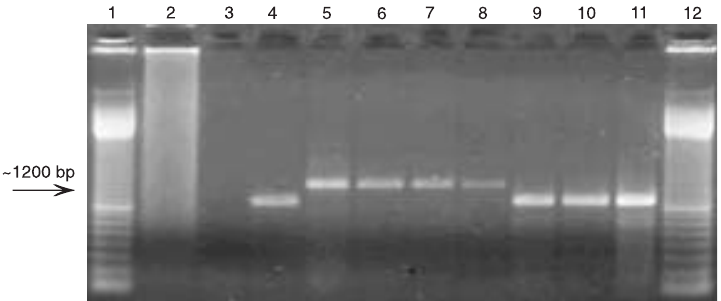
Figure 3. RT-PCR analysis for the detection of insertions in the NS2-3 gene in the cytopathic bovine viral diarrhea virus isolates. Lane 1 , Molecular weight marker (100-bp ladder); lane 2 , negative control; lane 3 , no template; lane 4 , Singer strain; lane 5 , NADL strain; lane 6 , isolate 26; lane 7 , isolate 44; lane 8 , isolate 63; lane 9 , isolate 13; lane 10 , isolate 33; lane 11 , isolate 73; lane 12 , molecular weight marker. RT-PCR products were submitted to 1% agarose gel electrophoresis, stained with ethidium bromide and visualized under UV light. The size of the amplified products from isolates containing inserts is indicated by the